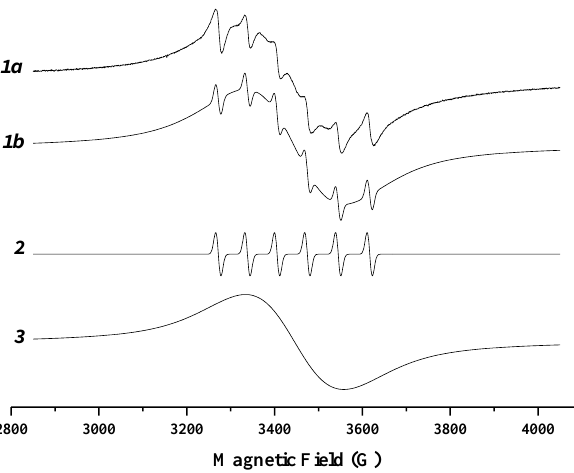
Figure 3. The EPR spectrum of Mn 2+ :ZnS:CdS/Zns nanoparticles measured at 293 K: 1a — the experimental spectrum, 1b — the sum of the 2 and 3 simulated spectra.